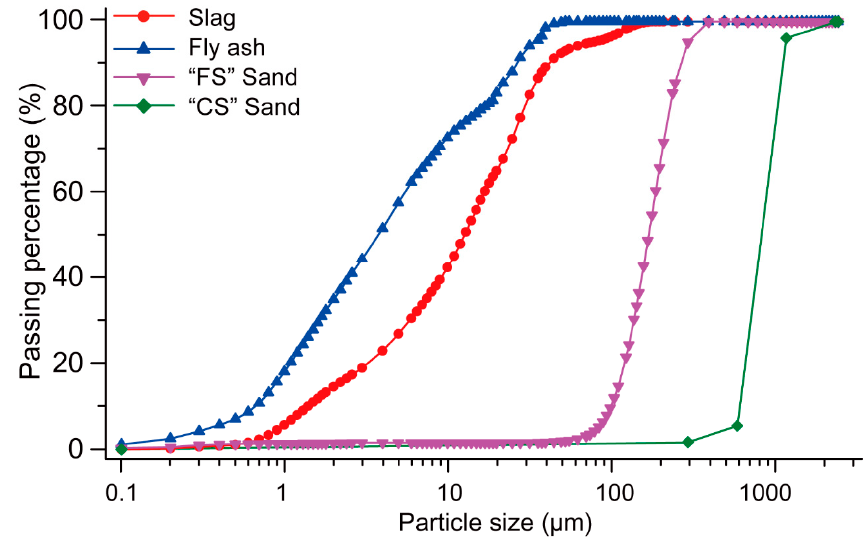
Figure 1. Particle size distributions of the fly ash, slag, fine sand (FS) and coarser sand (CS).